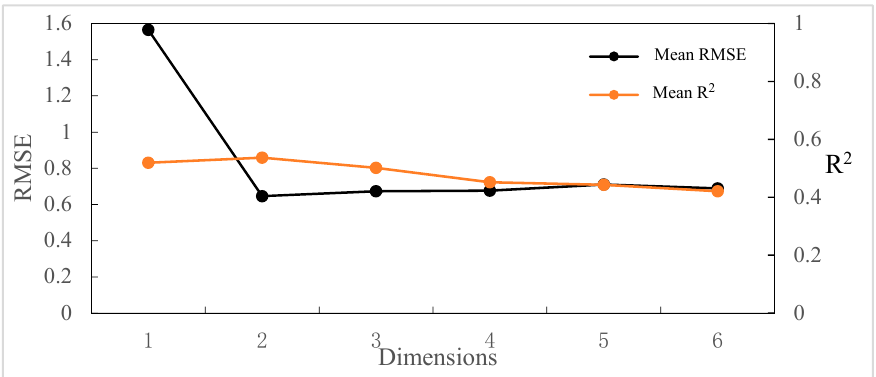
Figure 16. Performance of the LAI-TCA considering different dimensions.